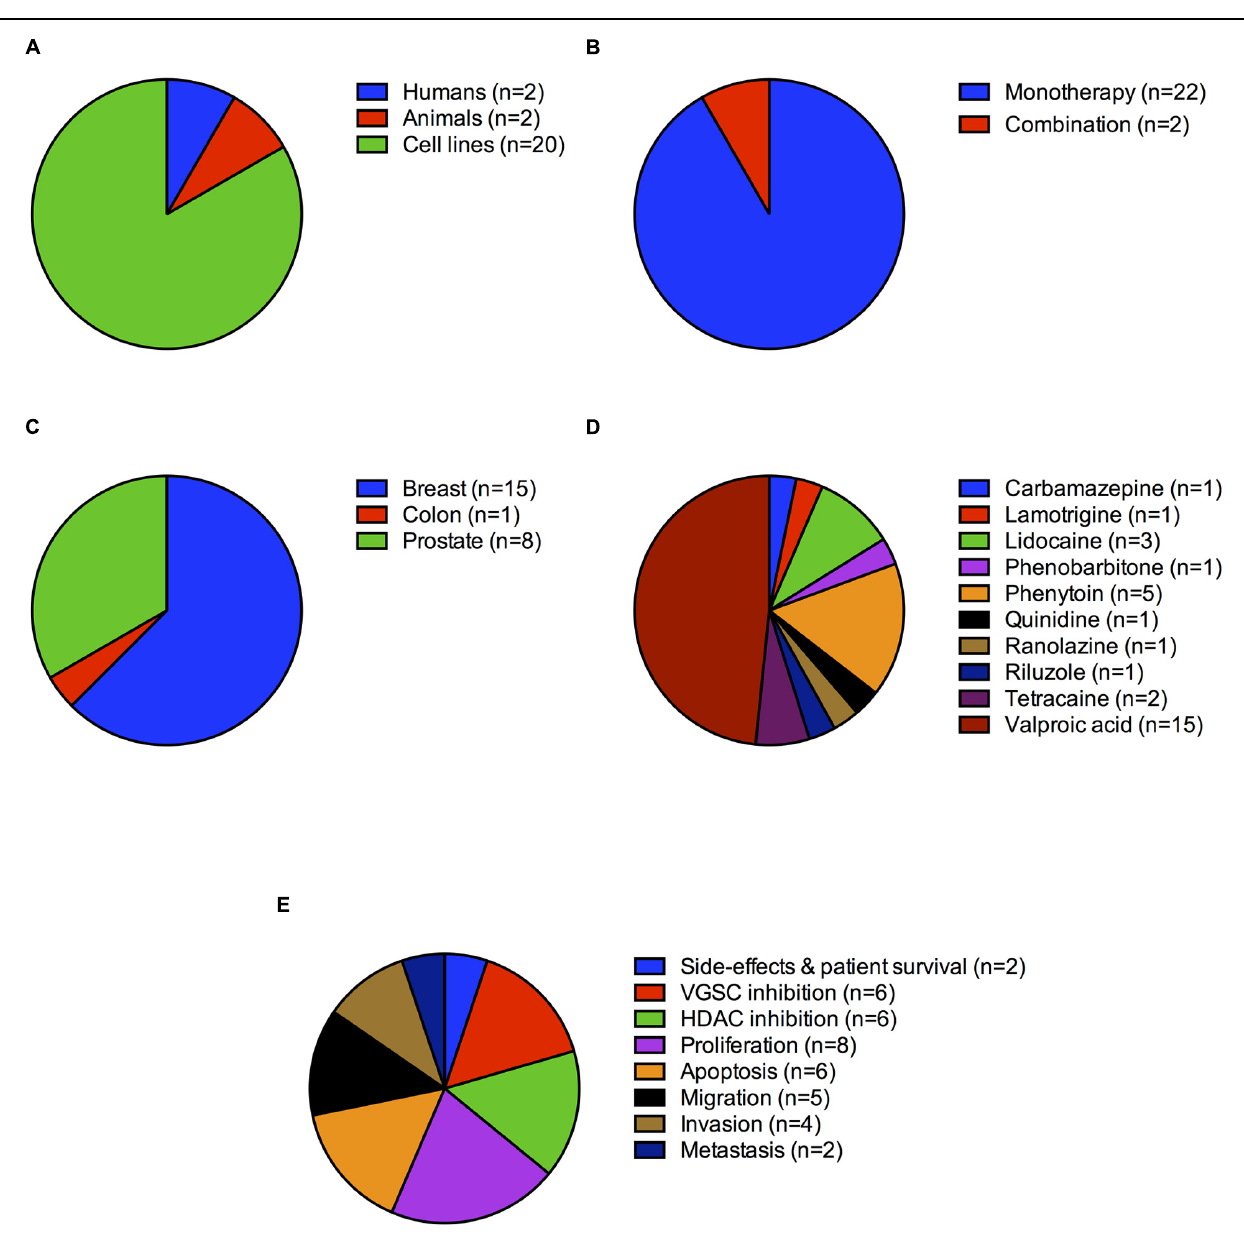
FIGURE 3 | Study distribution by cancer type, intervention and outcome measure. (A) Number of studies (%) on humans, animals and cell lines. (B) Number of studies (%) testing monotherapy vs. those testing multiple drugs in combination. (C) Number of studies (%) on breast, colon and prostate cancer. (D) Studies (%) divided by drug type. (E) Studies (%) divided by outcome